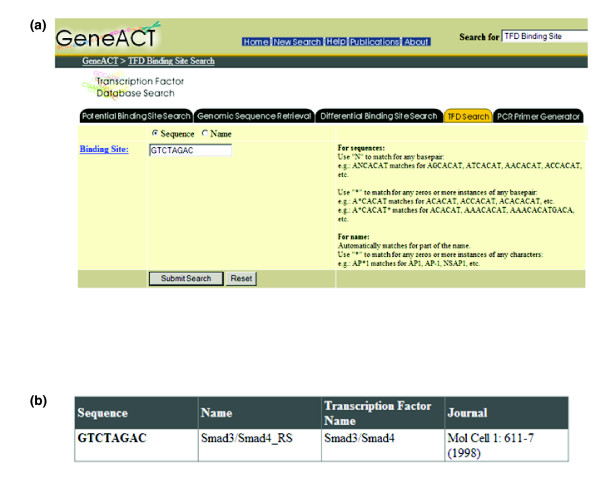
Search transcription factor binding site database. (a) Custom transcription factor database based on Transcription Factor Database (TFD). Database can be queried by sequence and name. New entries into the database can be added by the system administrator. (b) Display of the search result of a transcription factor binding site. The literature information of the binding site is shown.